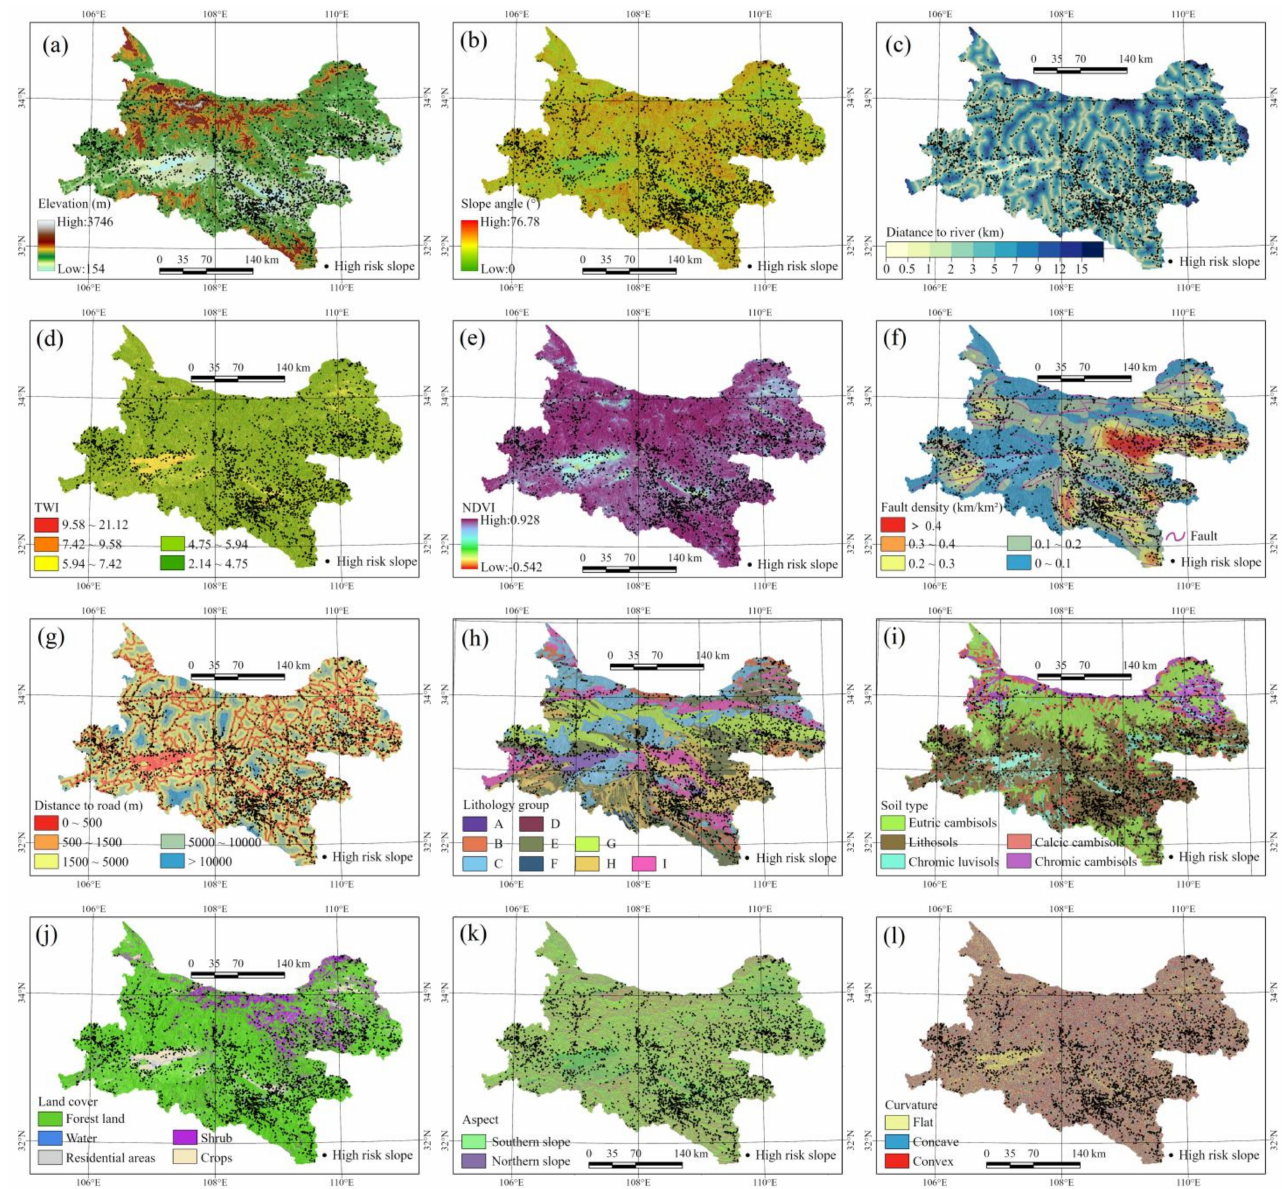
Figure 3. Thematic maps of the landslide-related geo-environmental factors: ( a ) elevation, ( b ) slope, ( c ) distance to river, ( d ) TWI, ( e ) NDVI, ( f ) fault density, ( g ) distance to road, ( h ) lithology group, ( i ) soil type, ( j ) land cover type, ( k ) aspect, and ( l ) profile